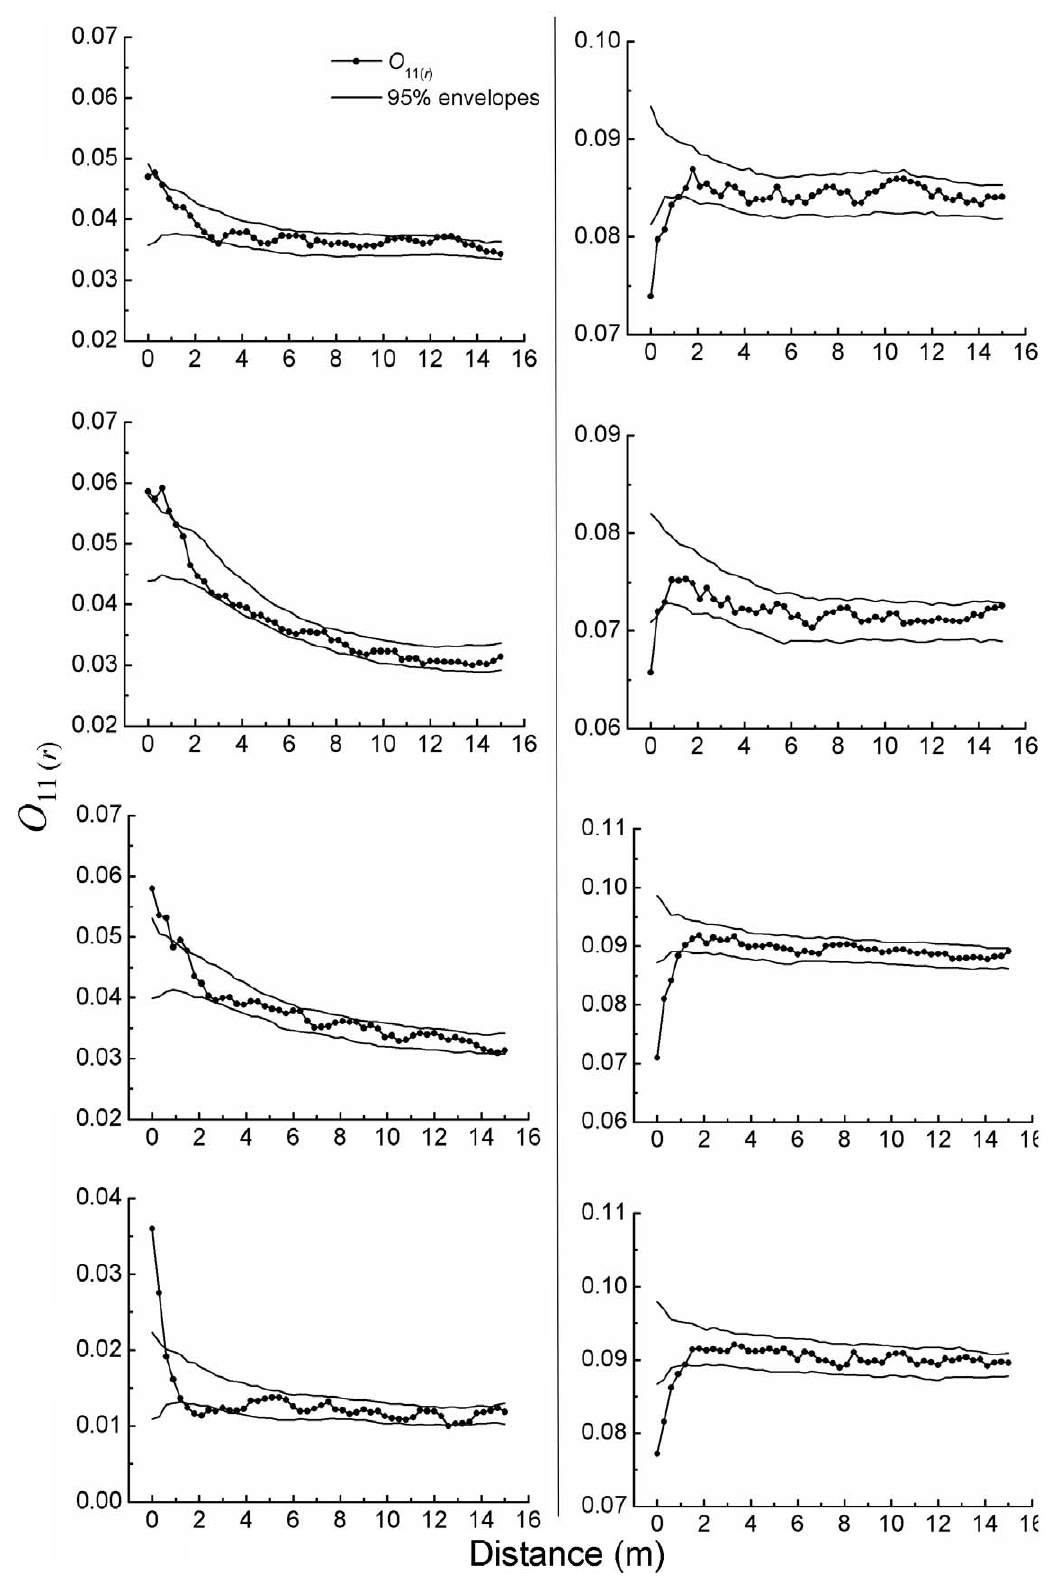
Figure 3. Spatial aggregation of A.ordosica adults at the patch edges (left column, a) and the patch centers (right column, b), one sub-figure per plot.